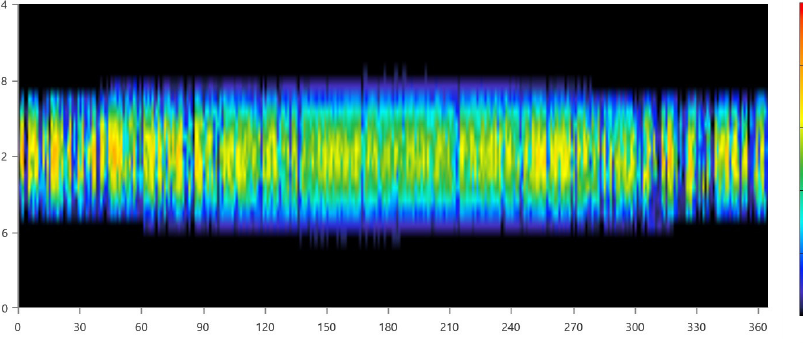
Fig. 5. Power output Huawei SUN2000 30kW with Generic PV